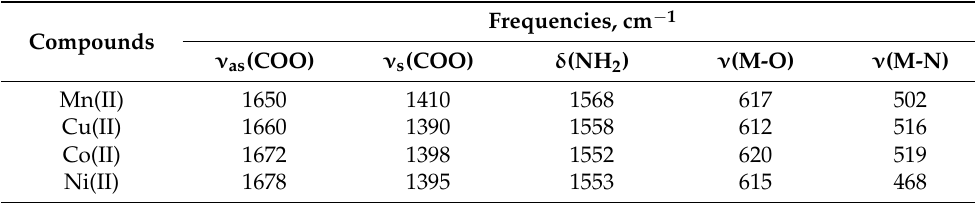
Figure 3. The infrared spectra of ( A ) Gpn free drug and ( B ) Mn(II), Co(II), Ni(II), and Cu(II)–Gpn complexes. Table 1. Infrared spectral data (cm −1 ) of Gpn and its complexes.